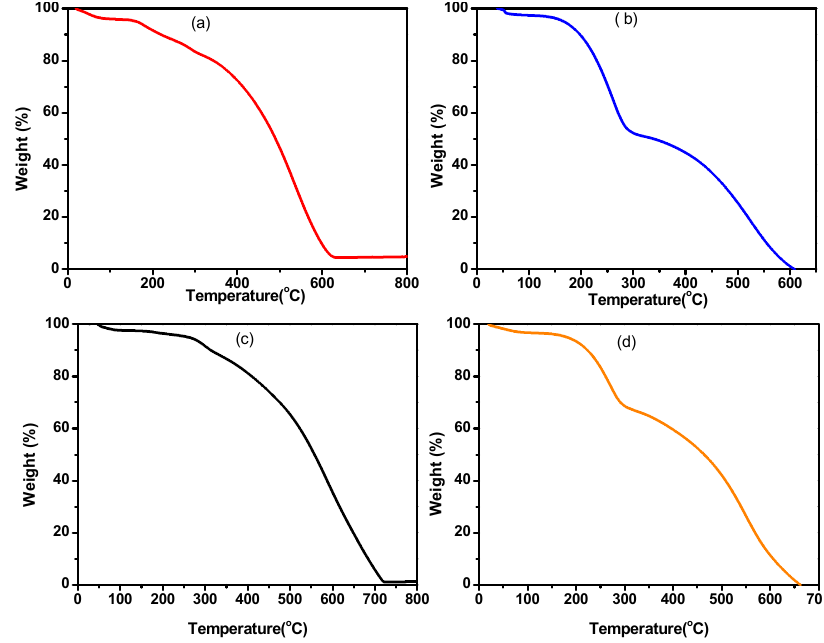
Figure 16. Thermograms of different ( a ) PANI A4 ( b ) PANI B9 ( c ) PANI D2 and ( d ) PANI S3.